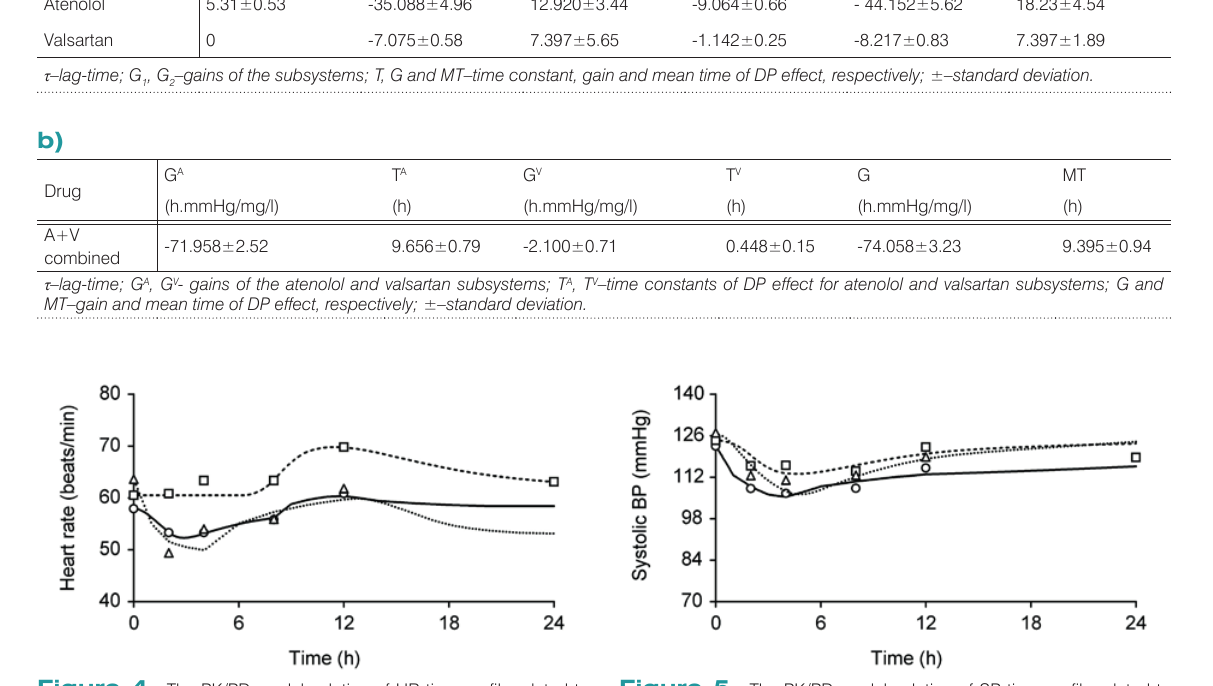
Figure 5. The PK/PD model solution of SP time profile related to measured atenolol (triangles), valsartan (squares) concentrations and their combination